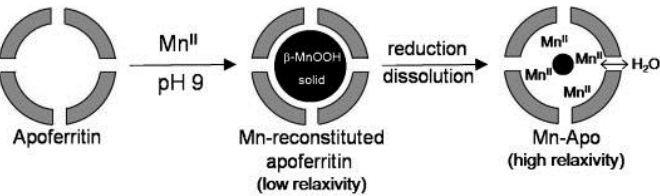
Figure 6. Mn‐Apo preparation. Reproduced with permission from [38] . Copyright John Wiley and Figure 6. Mn-Apo preparation. Reproduced with permission from [38]. Copyright John Wiley and Sons, 2010. Sons,